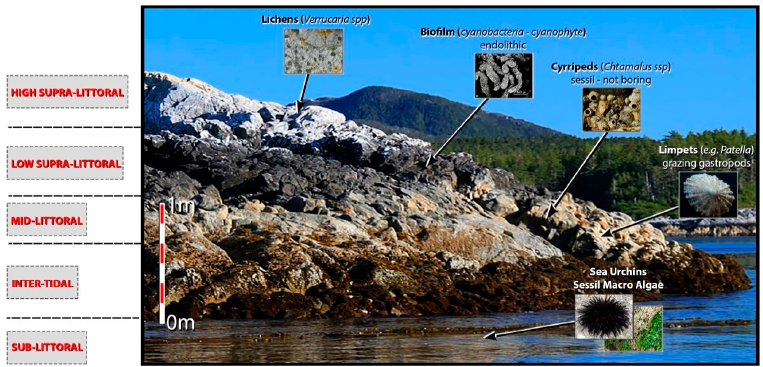
Figure 1. Biological community bands on a typical Mediterranean rocky shore (with a tidal range of 0.4–1 m).